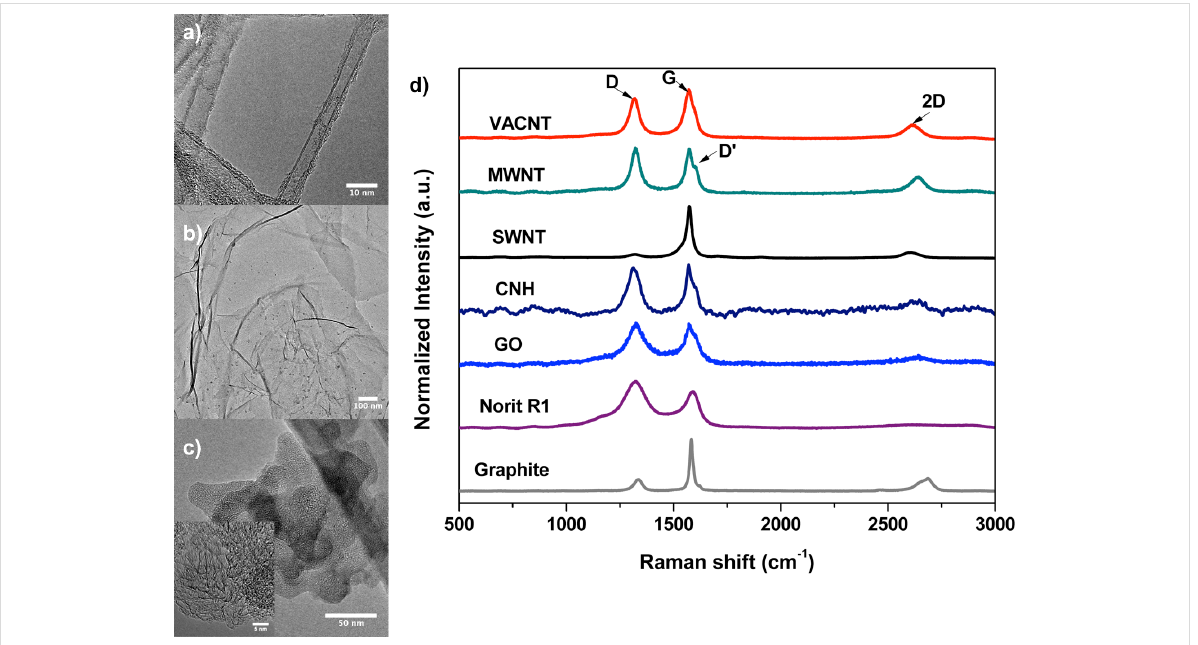
Figure 3: a) TEM image of VACNTs obtained after unhinging from the substrate and dispersed in ethanol by ultrasonication. b) TEM image of GO showing its characteristic wrinkled, layer like morphology c) TEM image of bud-like CNHs. Inset shows the high-magnification TEM image revealing the conical tips of CNHs. d) Overview of Raman spectra of the different adsorbents studied.